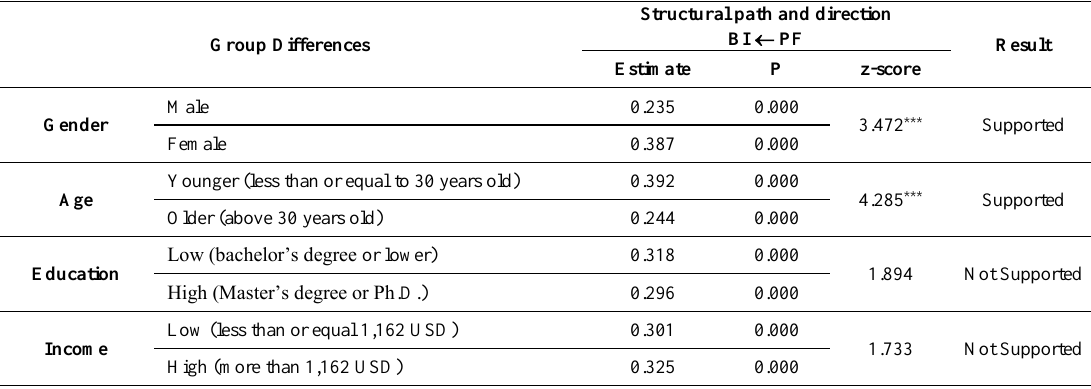
Table 6. Pathwise moderation effect: Group